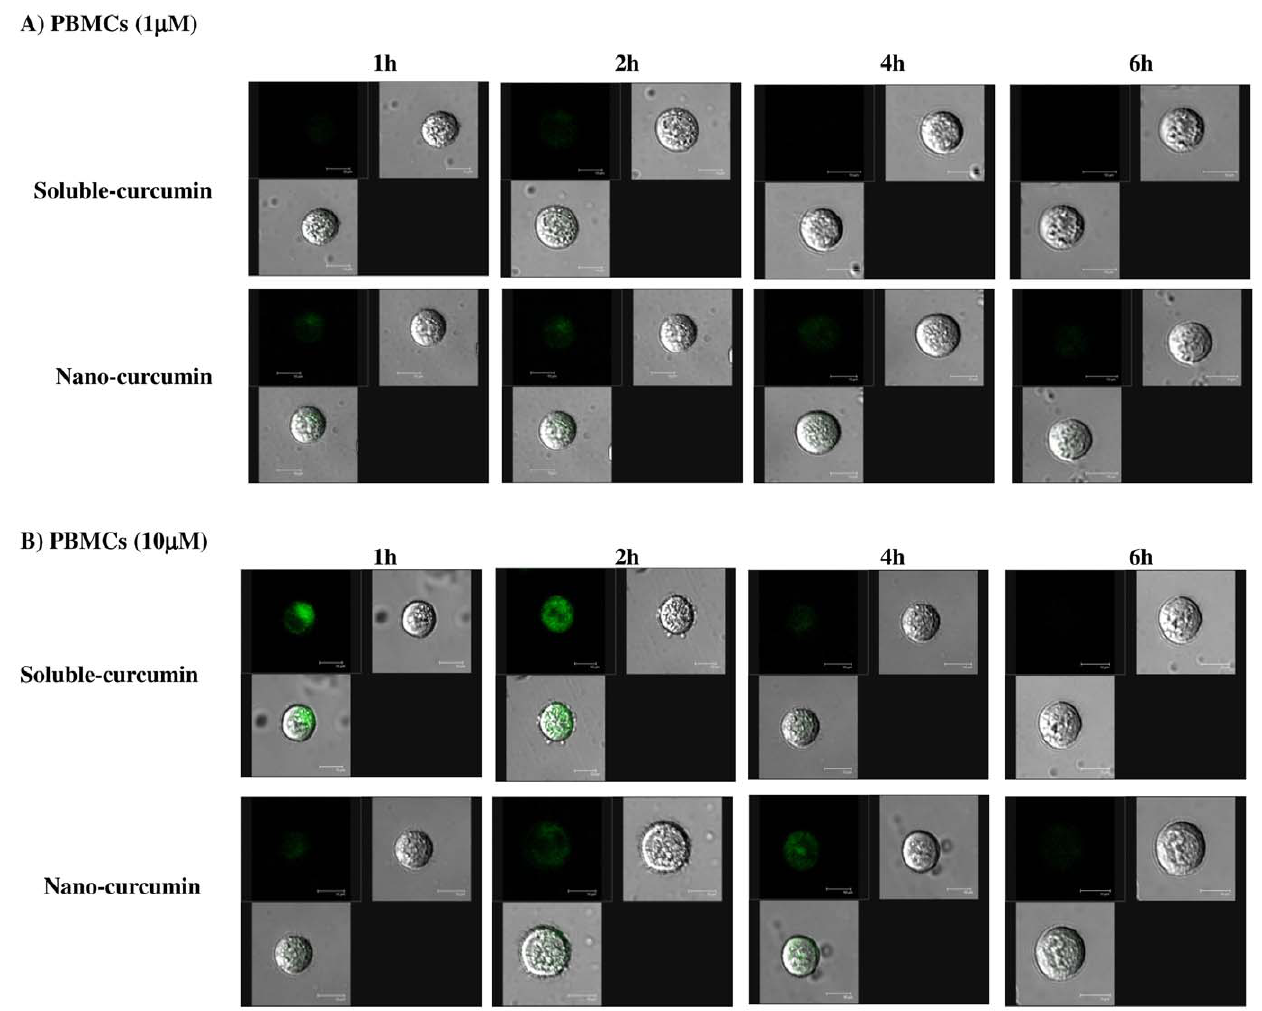
Figure 4. Nanoparticle formulation exhibits increased cellular retention in stimulated PBMCs. Cells were incubated with 1 m M (Panel A) and 10 m M (Panel B) sol-curcumin and nano-curcumin and examined by confocal microscopy at time points of 1, 2, 4 and 6 h. Each panel contains three images: fluorescence, bright field and merged.